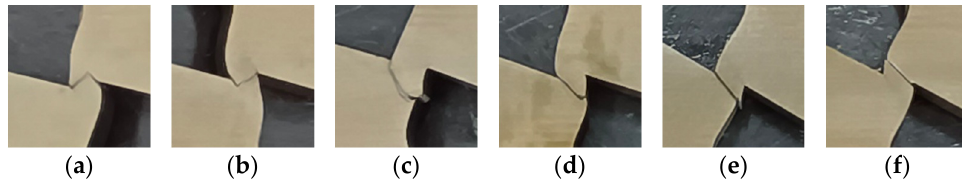
Figure 6. Fracture topography of tensile–shear flat plates: ( a ) FT-1 ( θ s = 15 ◦ ), ( b ) FT-2 ( θ s = 15 ◦ ), ( c ) FT-3 ( θ s = 20 ◦ ), ( d ) FT-4 ( θ s = 20 ◦ ), ( e ) FT-5 ( θ s = 30 ◦ ), ( f ) FT-6 ( θ s = 30 ◦